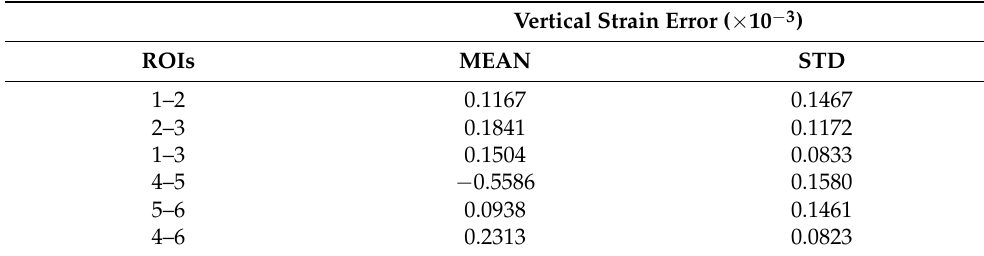
Table 2. Vertical strain error for a long-term still sequence of the recorded images.